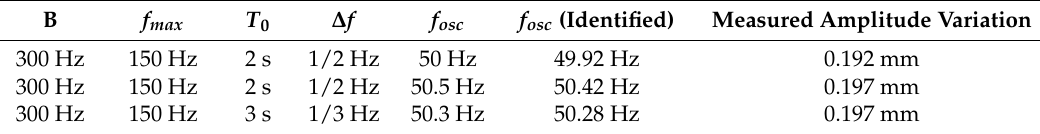
Table 6. Parameters and results of the first experimental validation tests (second set).